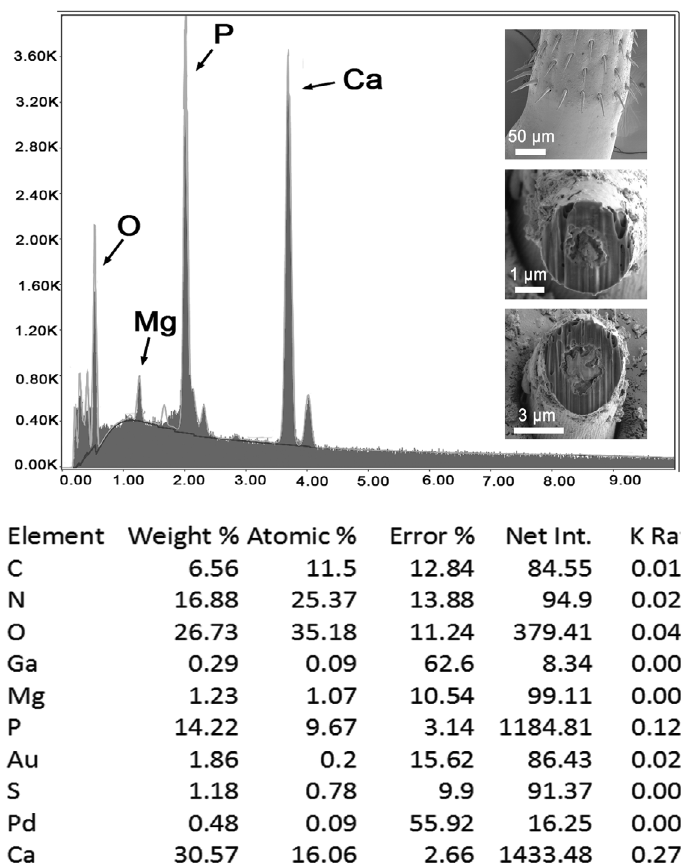
Figure 35. Energy Dispersive X-ray spectrum of the tip of a small hook of a Rhadinorhynchus laterospinosus specimen showing high levels of calcium and phosphorus but less calcium than large hooks (see Table 4). Insert: SEM of posterior hooks and hook tips in cross gallium cuts.